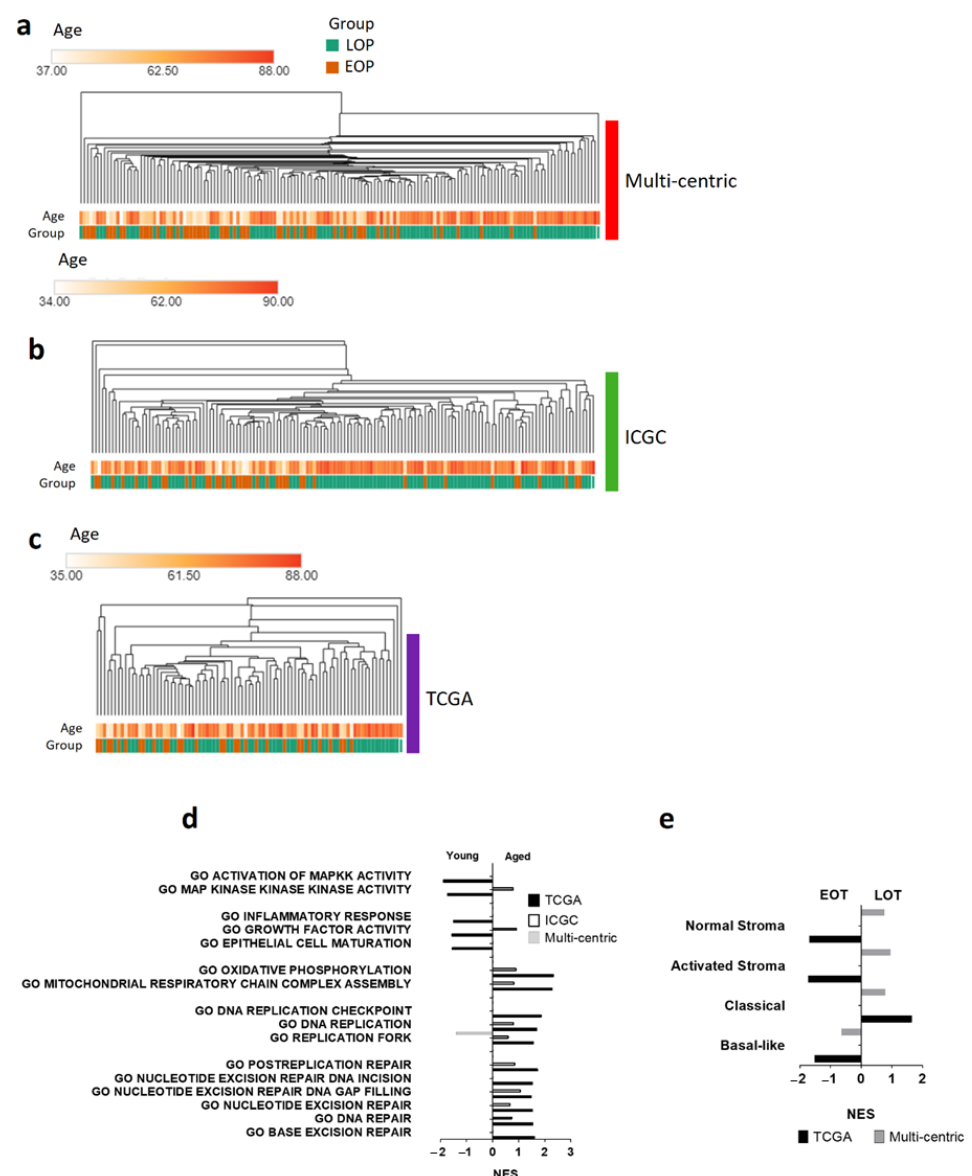
Figure 2. Transcriptomic landscape of early-onset patients (EOP) and late-onset patients (LOP). Hierarchical clustering of EOP (orange) and LOP (green) from ( a ) Multi-centric cohort; ( b ) ICGC_PAN_AU cohort; ( c ) TCGA_PAAD cohort. ( d , e ) Gene set analysis (GSEA) of LOP vs. EOP from each dataset. Normalized Enrichment Score (NES) with a false discovery rate less than 0.25, and a p value less than 0.05. ( d ) GSEA of gene ontology (GO); ( e ) GSEA of Moffitt et al. PDAC subtype signature [10].